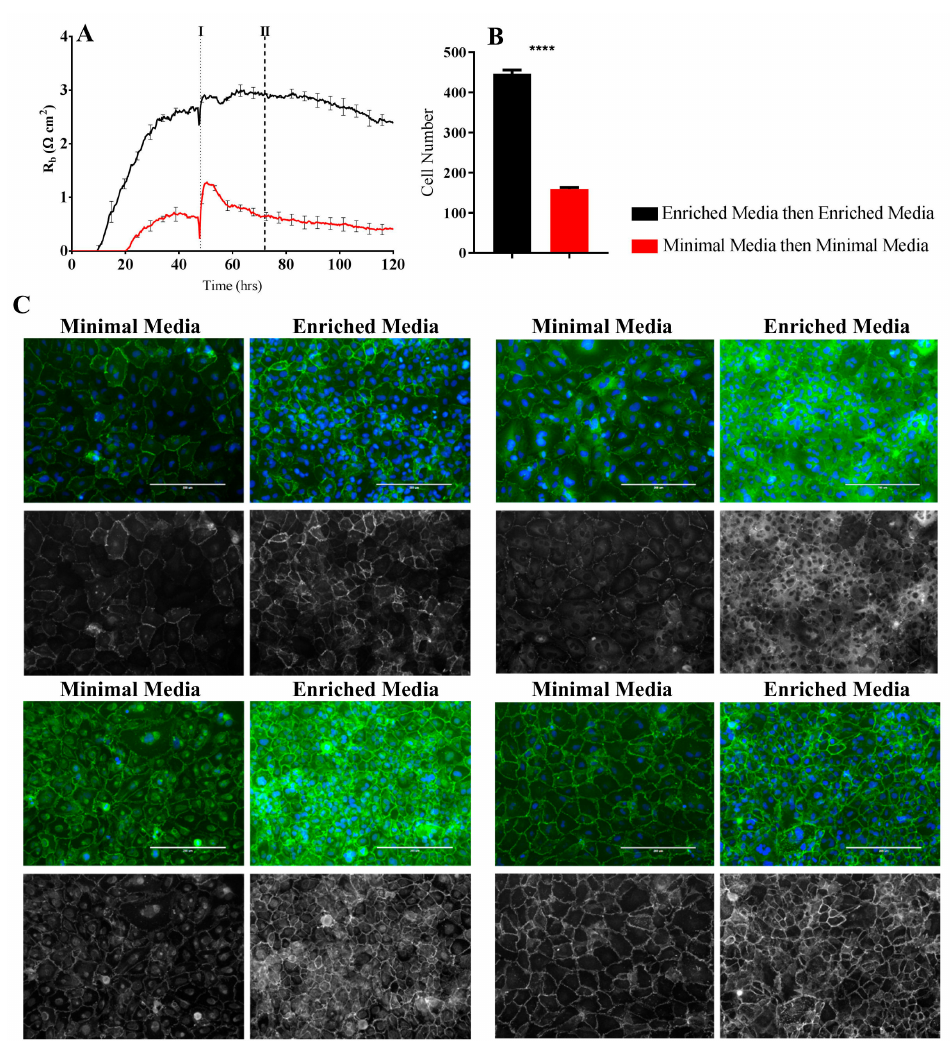
Figure 6. Immunocytochemistry of brain endothelial junctional space following growth in either Enriched Media or Minimal Media. Cells were seeded at time 0 h at 20,000 cells per 0.3 cm 2 . ( A ) ECIS resistance and R b measurements over 120 h. Cells were grown in either Enriched Media or Minimal Media from T = 0 h, with media changed at T = 48 h (I). Data shown is the mean ± SD (n = 3 wells) of one independent experiment representative of three experimental repeats; ( B ) Cell number count of Hoechst stained nuclei at time point II, obtained through Image J Software analysis. Data shown is the mean ± SEM (n = 18 wells) of 1 independent experiment representative of 3 experimental repeats; ( C ) The junctional space following growth in either Enriched Media or Minimal Media 72 h post seeding. The time point of fixation corresponds to the second vertical dotted line (II) shown on the ECIS traces. Representative GFP/DAPI and GFP monochrome images for the junctional proteins CD144, ZO-1, β -catenin, and α -catenin are shown. Each panel shows cells grown in Minimal Media on the left and cells grown in Enriched Media on the right. The corresponding Alexa Fluor 488 (GFP) monochrome image is shown below each merged image. Green—junctional protein, blue—nuclei. Scale bar is 200 µ m. Immunocytochemistry data show one representative image from one independent experiment, which is representative of three experimental repeats. Graphical representations of p values are * p ≤ 0.05, ** p ≤ 0.01, *** p ≤ 0.001, **** p ≤